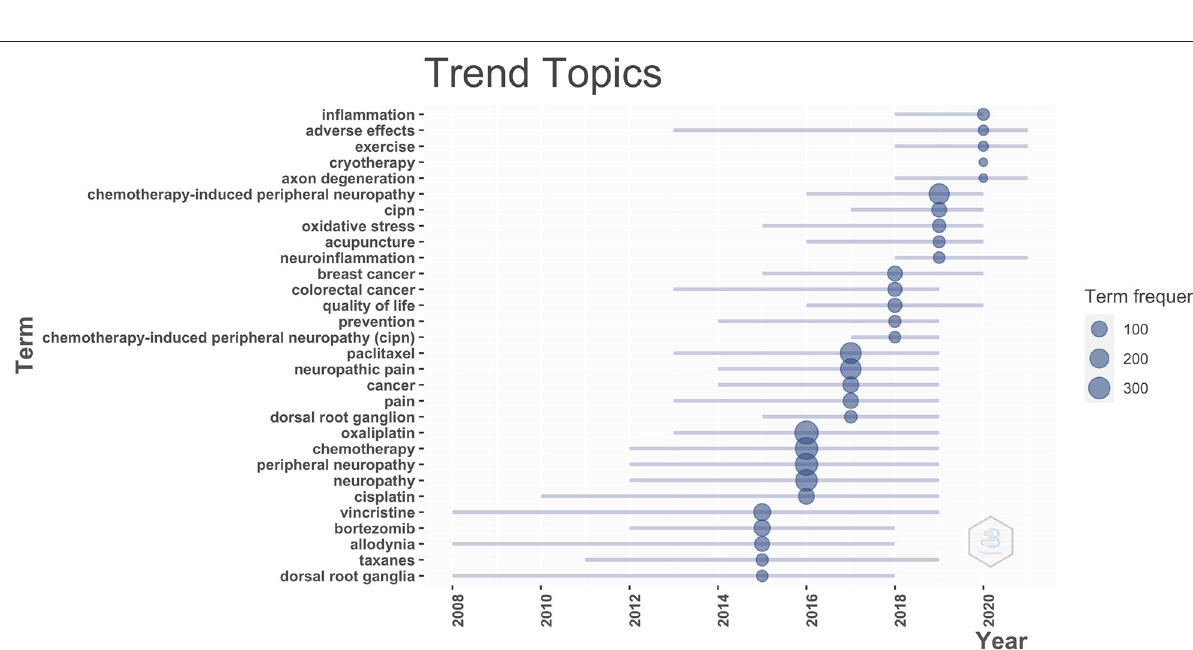
FIGURE 5 | Timeline of research trends in the field of